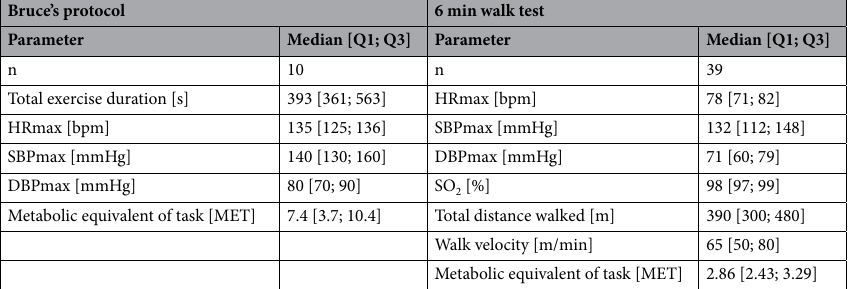
Table 4. Baseline characteristics of group S–CPX results. Data are presented as median [Q1; Q3]. bpm: beats per minute; CPX: cardiac stress test; DBPmax: maximum diastolic blood pressure; HRmax: maximum heart rate; MET: metabolic equivalent of task; Q1: first quartile; Q3: third quartile; SBPmax: maximum systolic blood pressure; SO 2 : blood oxygen saturation at the completion of 6 min walk